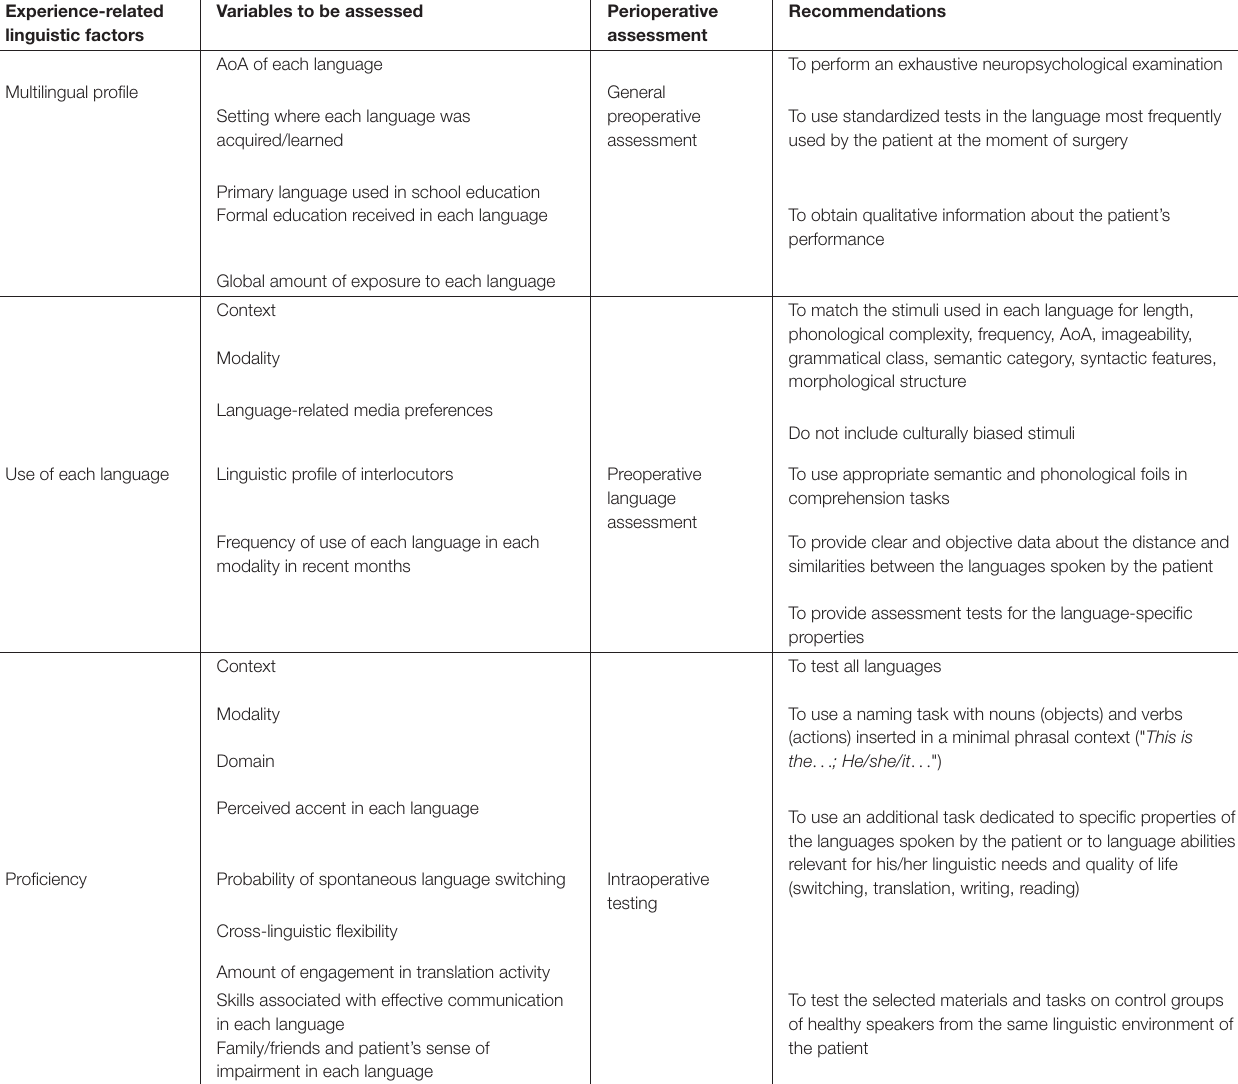
TABLE 7 | Recommended perioperative assessment procedures in multilingual awake neurosurgery